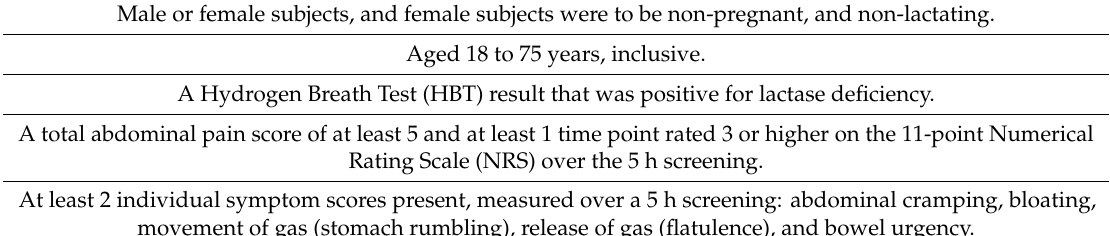
Table 1. Diagnosis and Main Criteria for Inclusion. Male or female subjects, and female subjects were to be non-pregnant, and non-lactating. Aged 18 to 75 years, inclusive. A Hydrogen Breath Test (HBT) result that was positive for lactase deficiency. A total abdominal pain score of at least 5 and at least 1 time point rated 3 or higher on the 11-point Numerical Rating Scale (NRS) over the 5 h